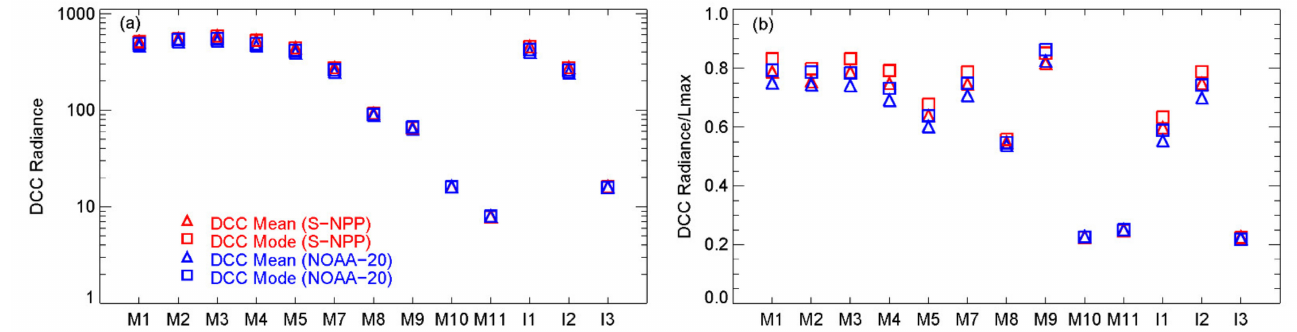
Figure 10. ( a ) Typical VIIRS RSB radiances over DCCs, and ( b ) ratios between typical VIIRS RSB DCC radiances and Lmax specifications. The unit of DCC radiance is W/(m 2 sr µ